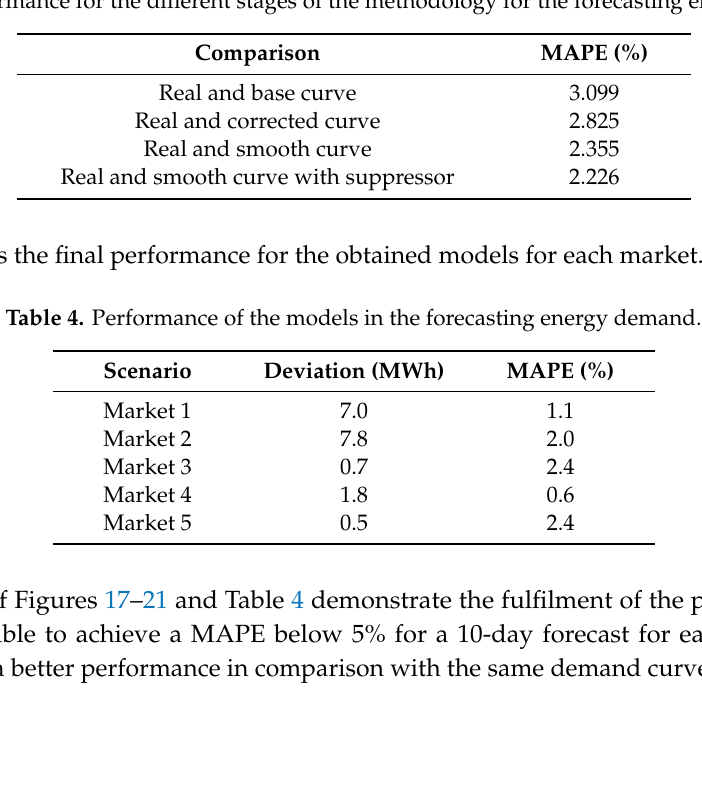
Table 3. Performance for the di ff erent stages of the methodology for the forecasting energy demand.